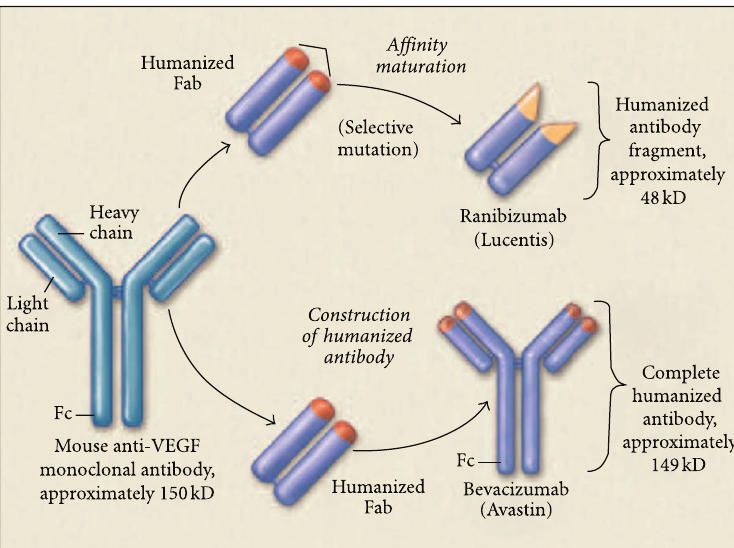
Figure 1: Ranibizumab is a recombinant humanized monoclonal antibody fragment. Bevacizumab is a recombinant humanized IgG antibody. Both bind to and inhibit all biologically active forms of VEGF-A and are derived from the same mouse monoclonal antibody. Ranibizumab has been genetically engineered to bind with higher a ffi nity than bevacizumab (see